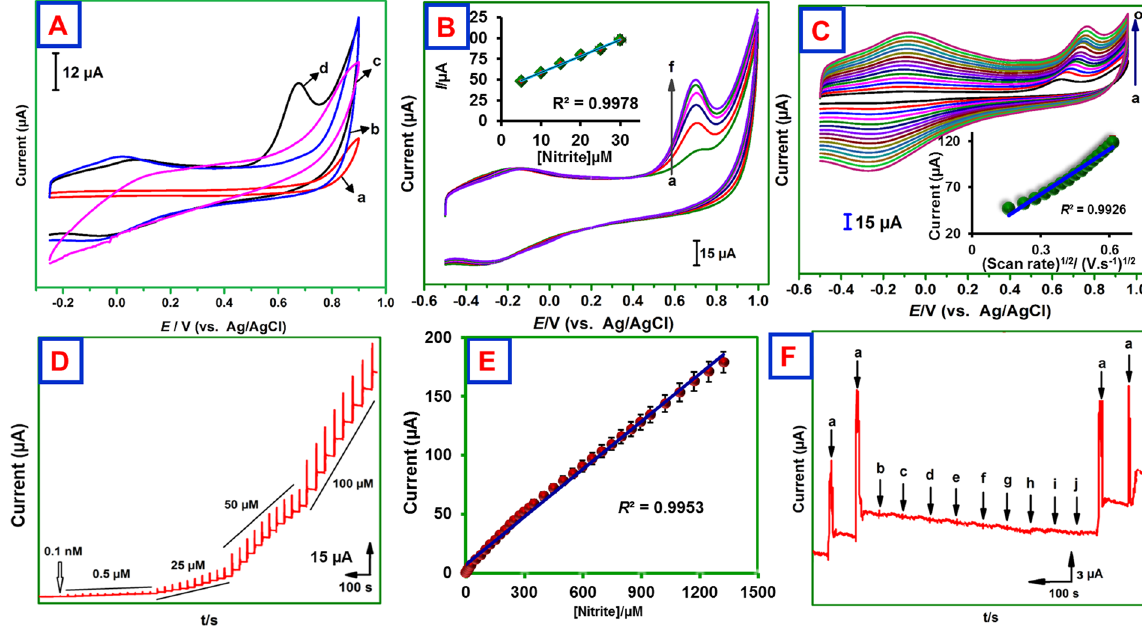
Figure 5. ( A ) CVs obtained at GCE/CHIT/Mb (a), GCE/MWCNTs@rGONRs/Mb (b), GCE/MWCNTs/ CHIT/Mb (c) and GCE/MWCNTs@rGONRs/CHIT/Mb (d) in phosphate buffer (pH 7) containing 5 µ M NO 2 − . Scan rate = 50 mV s − 1 . ( B ) CVs obtained at MWCNTs@rGONRs/CHIT/Mb/GCE in phosphate buffer (pH 7.0) containing different concentrations of NO 2 − (a = 5.0, b = 10.0, c = 15.0, d = 20.0 and e = 30.0 µ M). ( C ) CVs obtained at GCE/MWCNTs@rGONRs/CHIT/Mb in phosphate buffer (pH 7.0) containing 5 µ M NO 2 − at different scan rates from (0.02 to 0.3 Vs − 1 (a = 0.02, b = 0.04, c = 0.06, d = 0.08, e = 0.10, f = 0.12, g = 0.14, h = 0.16, i = 0.18, j = 0.20, k = 0.22, l = 0.24, m = 0.26, n = 0.28 V and o = 0.30 s − 1 ). ( D ) Amperometric response of MWCNTs@rGONRs/CHIT/Mb electrode upon successive additions of NO 2 − into phosphate buffer (pH 7.0). Rotation rate = 1200 rpm; E app = + 0.70 V. ( E ) Calibration plot of [nitrite] vs. response current. ( F ) The